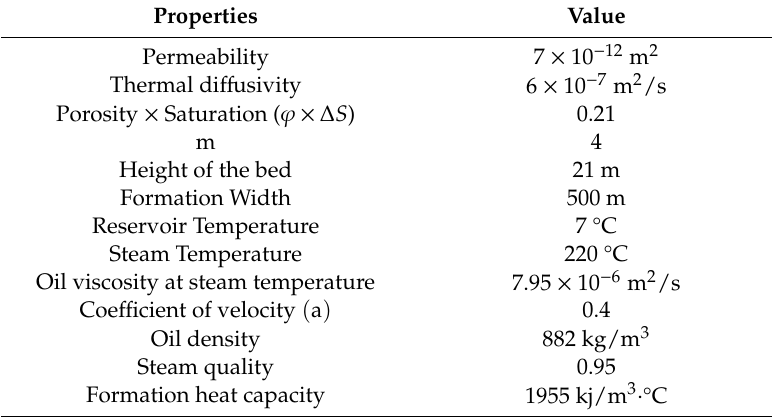
Table 2. Athabasca reservoir properties, the UTF project, Phase B [5]. Reproduced with permission from (Sabeti et al.), (Journal of Petroleum Science and Engineering); published by (Elsevier),